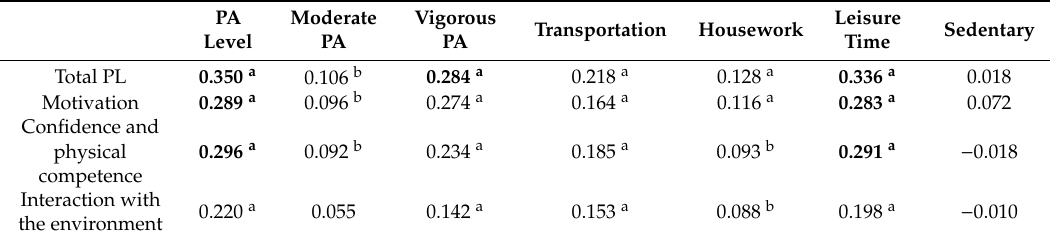
Table 1. Pearson’s product-moment correlation of 3 attributes of perceived physical literacy (PL) and physical activity (PA) domains ( n = 536).